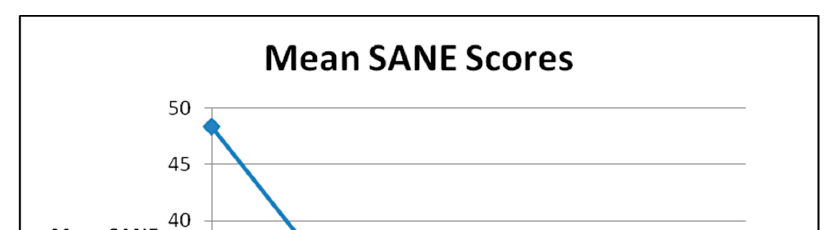
Figure 1. Mean Global Improvement.